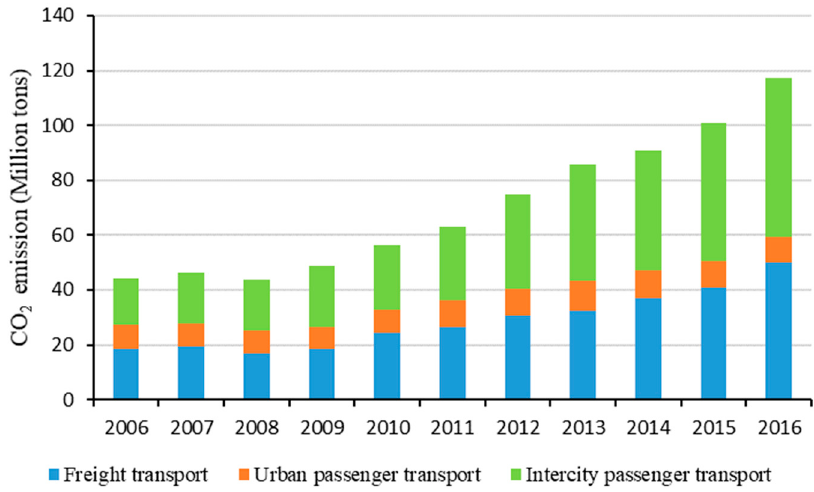
Figure 5. CO 2 emissions from passenger and freight transport of the Pearl River Delta, 2006 – 2016.